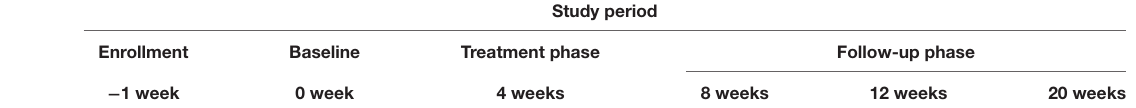
TABLE 1 | A process chart of the